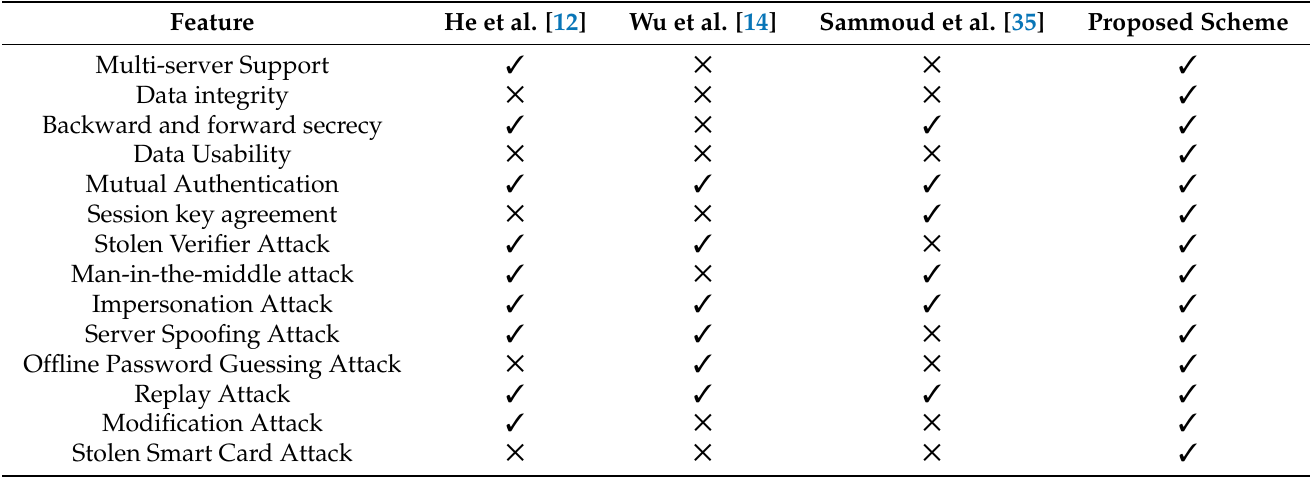
Table 3. Security feature